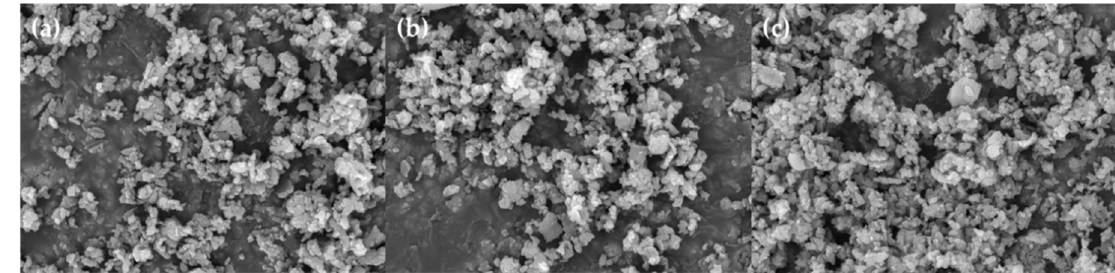
Figure 7. SEM image of first carbonate in 5 wt % MEA, DEA, and MDEA solutions: ( a ) formed precipitates in MEA solution, ( b ) formed precipitates DEA solution, and ( c ) formed precipitates MDEA solution.